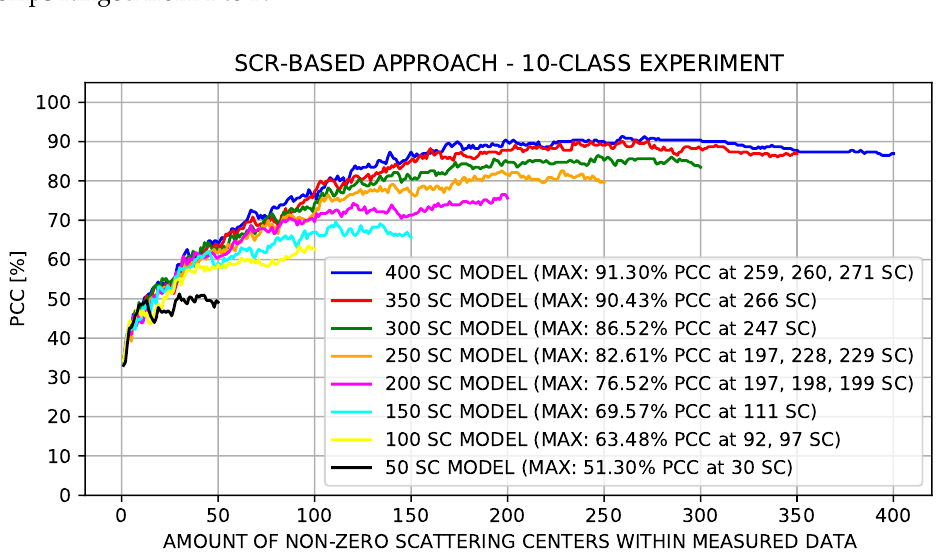
Figure 14. SCR-based approach experiments considering the number of non-zero scattering centers in the measured